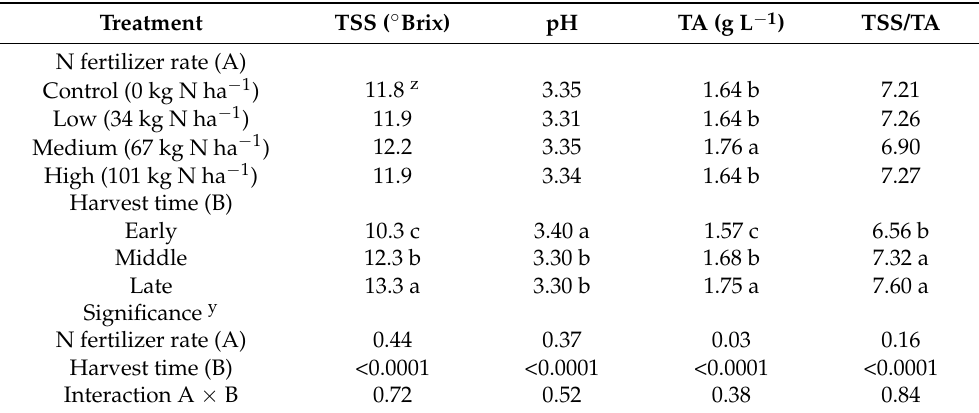
Table 3. Total soluble solids (TSS), fruit pH, titratable acidity (TA), and total soluble solids-to-titratable acidity ratio (TSS/TA) of the “Meeker” floricane red raspberry fertilized with different nitrogen (N) fertilizer rates,